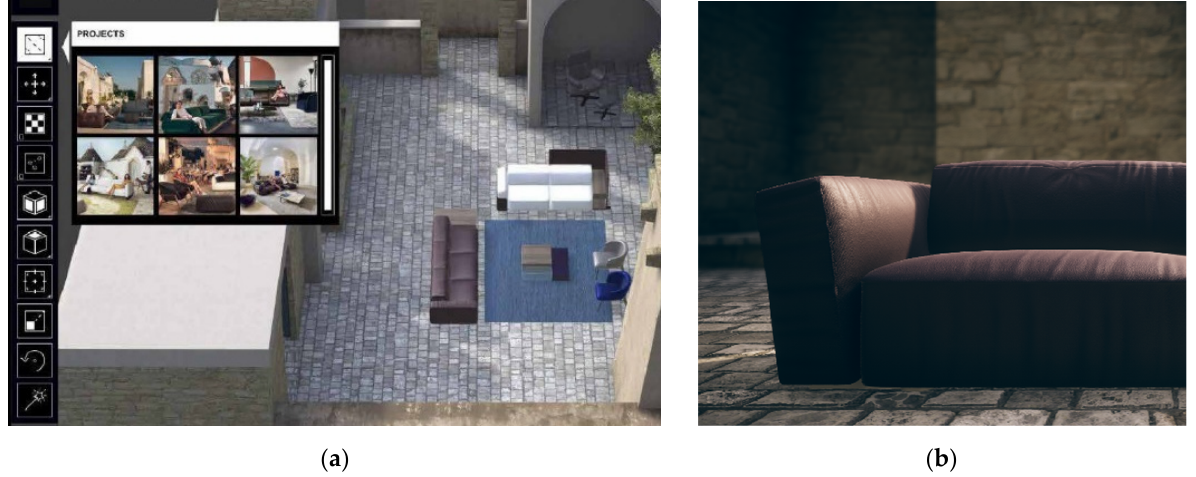
Figure 4. ( a ) The sales assistant interface with its features; ( b ) what the customer sees, including a realistic product rendering inserted in an evocative